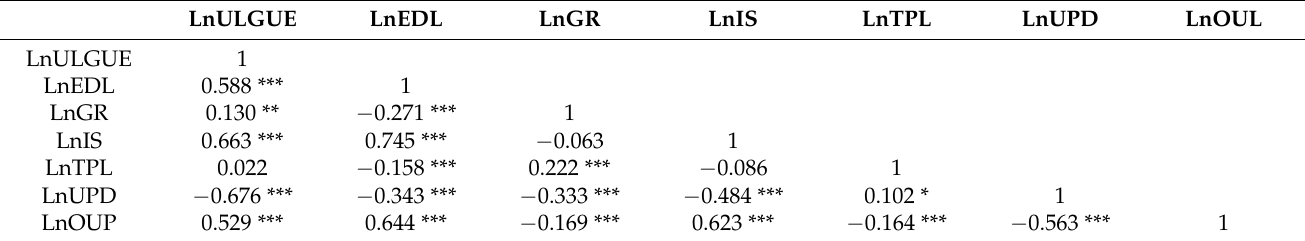
Table 8. The correlation test.